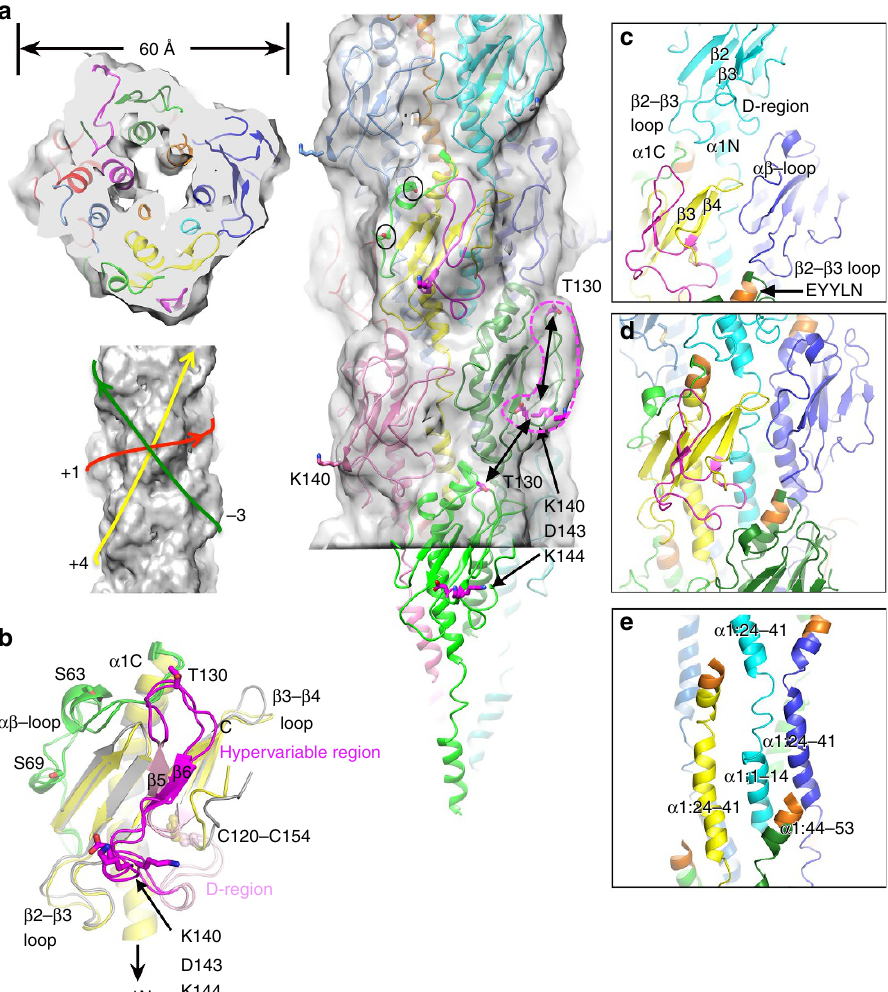
Figure 4 | Structure of the N. meningitidis T4P. ( a ) End and side view of the Nm T4P model fit into the cryoEM density, with each subunit shown in a different colour. In the side view the central subunit is coloured yellow with the ab -loop (residues 54–79) in green and the D-region (120–154) in magenta. Circled residues Ser63 and Ser69 within the ab -loop are post-translationally modified in the native T4P but these modifications are not resolved in the cryoEM reconstruction. The hypervariable region (127–146) within the D-region forms a ridge on the filament surface, indicated by the broken magenta line for one subunit. Residues Thr130, Lys140, Asp143 and Lys144 within the hypervariable ridge in this subunit and the adjacent green subunit are shown in stick representation with carbon atoms coloured magenta. These two b 2AR interaction sites are spaced equidistant apart ( B 26Å) within a subunit and between subunits, as indicated by the double-headed arrows. The connectivity of the subunits is shown on the left below the end view. ( b ) Superposition of Nm D N-PilE before (grey, green and magenta) and after refinement in the pilus model (yellow, green and magenta). The D-region is coloured light pink and the hypervariable ridge within the D-region is coloured magenta. ( c ) Globular domain interactions shown from the perspective of the central subunit coloured as in ( a ), with the EYYLN epitope coloured orange. ( d ) The globular domains and their corresponding a 1:24–41 segments follow the þ 1-start helix and sandwich between them a 1:1–14 from subunits in the preceding turn of the þ 1-start helix. ( e ) Interactions among a 1s as shown in d but with residues 54–161 of the globular domains removed for clarity. a 1 segments are